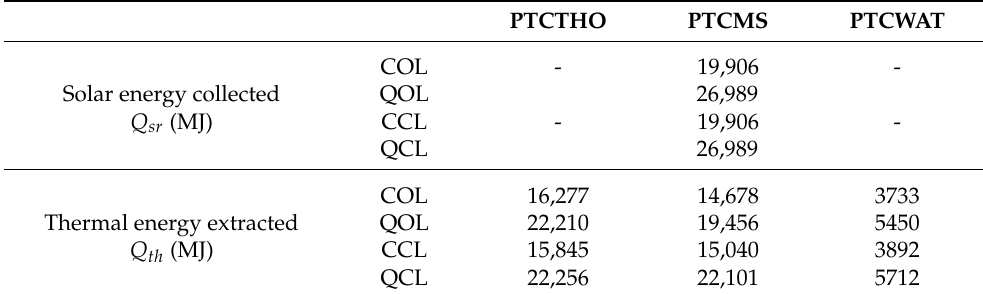
PTCTHO PTCMS PTCWAT